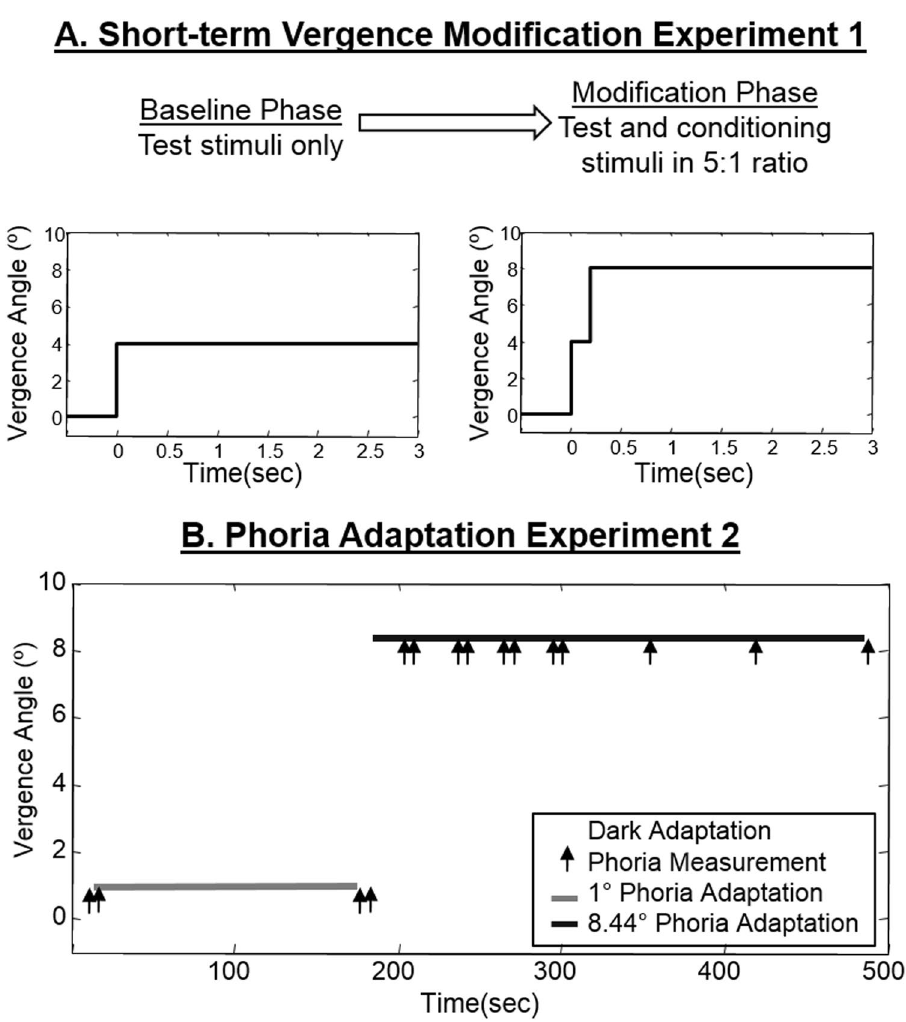
Figure 1. Experimental protocol of ( A ) the short-term vergence modification for Experiment 1 and ( B ) the phoria adaptation for Experiment